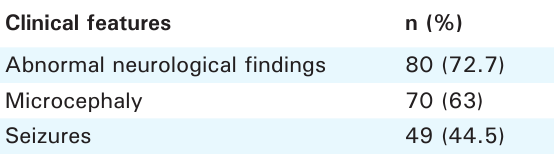
Table 2. Associated features with